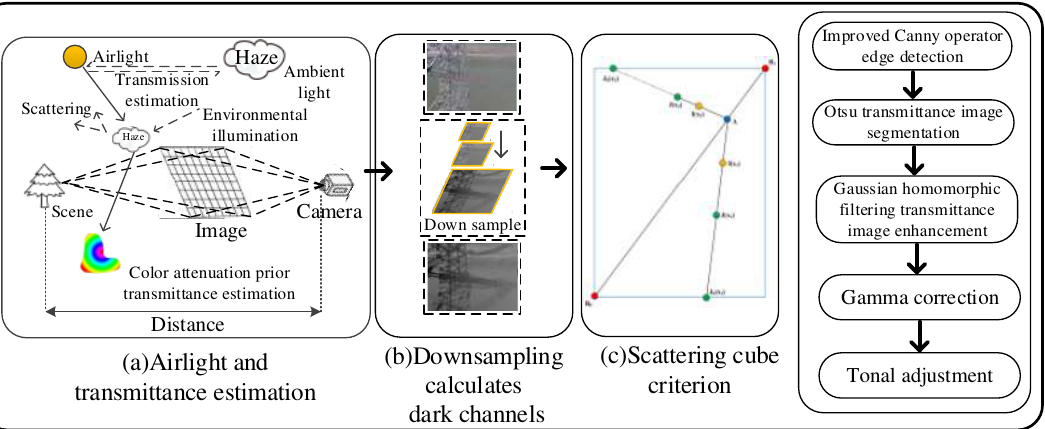
Figure 5. Overall flow chart of defogging algorithm.